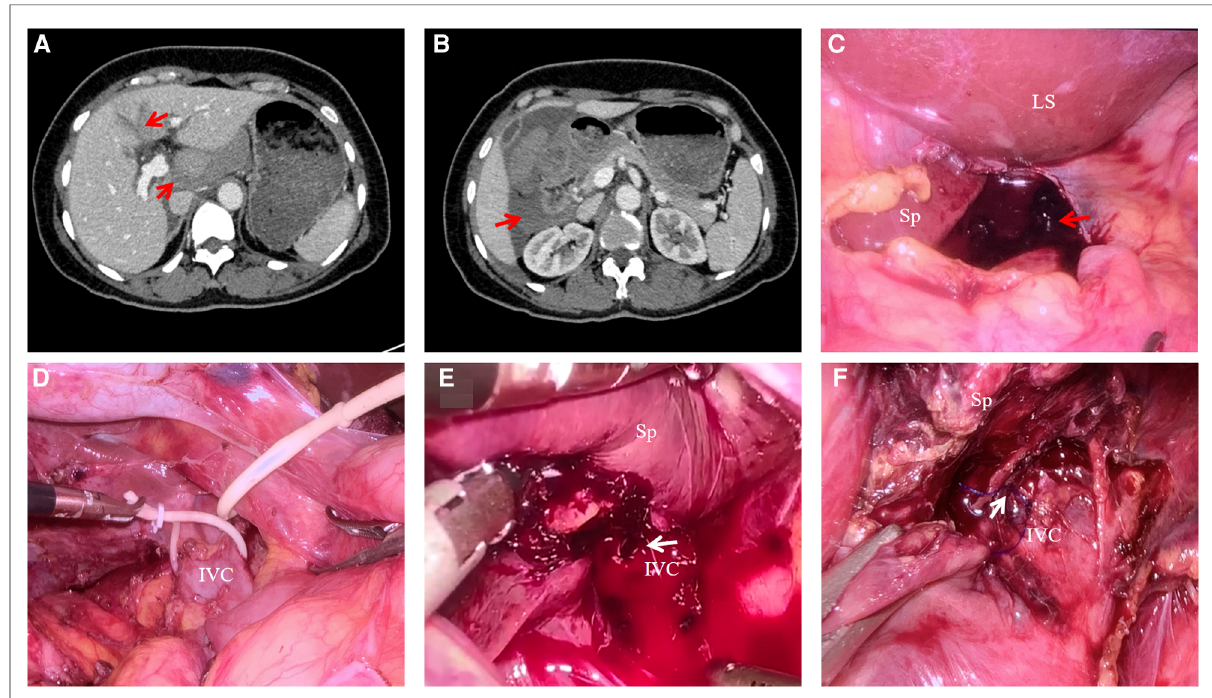
FIGURE 1 CT scan of liver trauma and procedure of laparoscopy by infrahepatic IVC clamping. ( A ) CT scan showing liver laceration involving segments I and IV; ( B ) CT scan showing extensive hemoperitoneum around the liver; ( C ) laparoscopy showing the perihepatic hemorrhage and blood clot; ( D ) infrahepatic IVC taped with a vessel loop; ( E ) laceration in the anterior wall of retrohepatic IVC was clearly exposed by laparoscopy without bleeding in the condition of the Pringle maneuver and infrahepatic IVC partial clamping; ( F ) laceration was safely sutured. Sp, spiegel lobe; Ls, left lateral